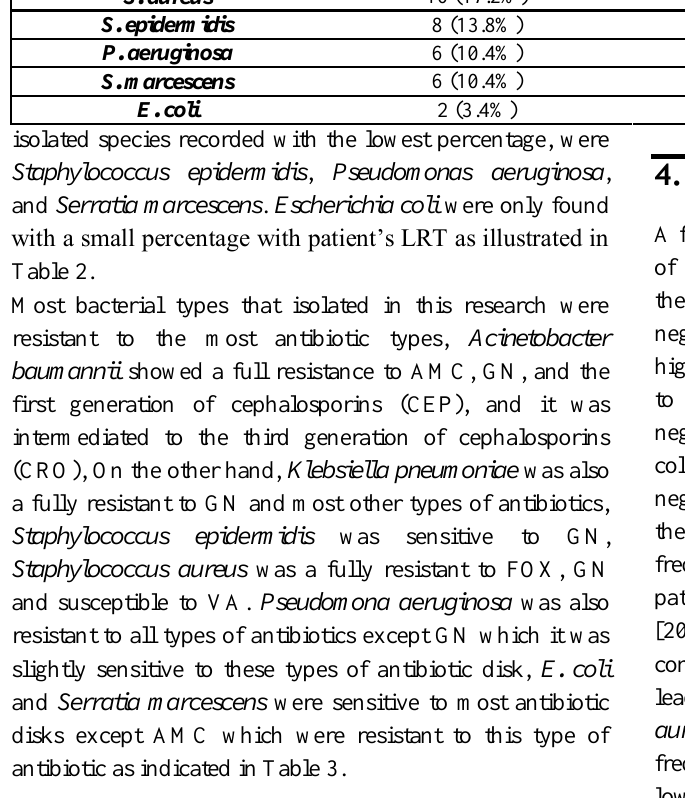
Table 3. Antibiotic resistance pattern of isolated bacteria from ventilator circuits and patients